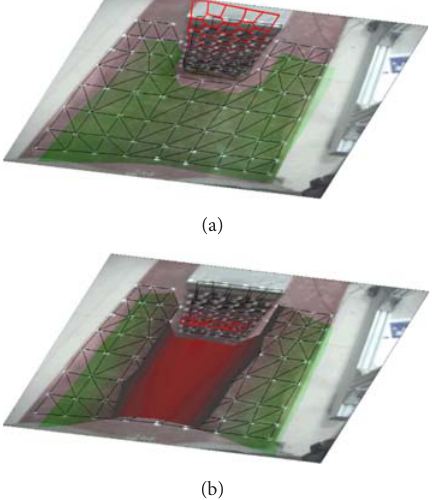
Figure 21: Two-node vertical mode shape of the verification base: (a) mode shape of the auxetic cellular base and (b) mode shape of the steel grillage.